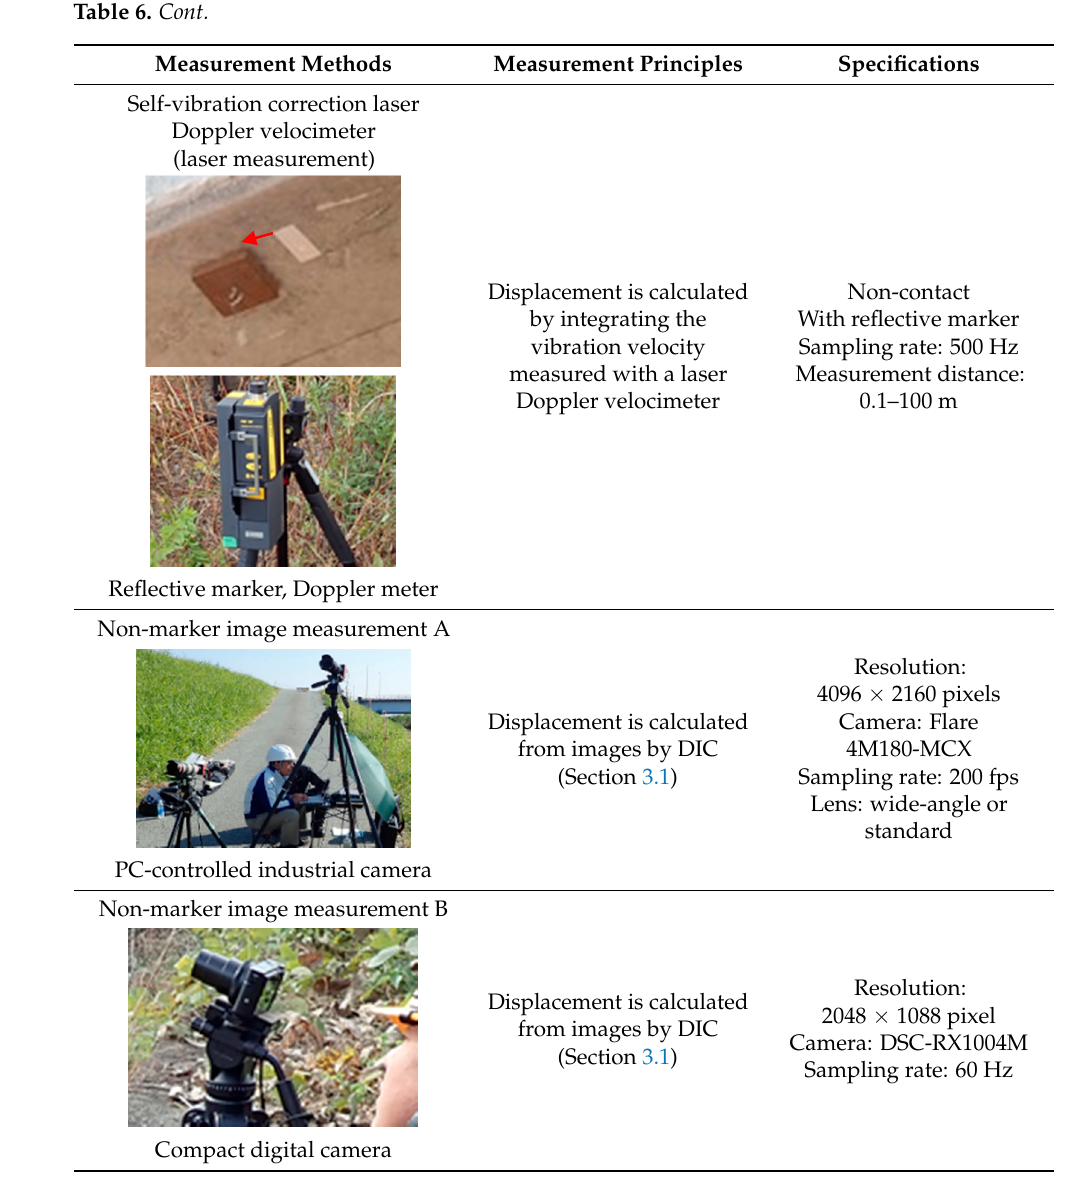
Figure 8. Installation status of each measuring device for bridge B.